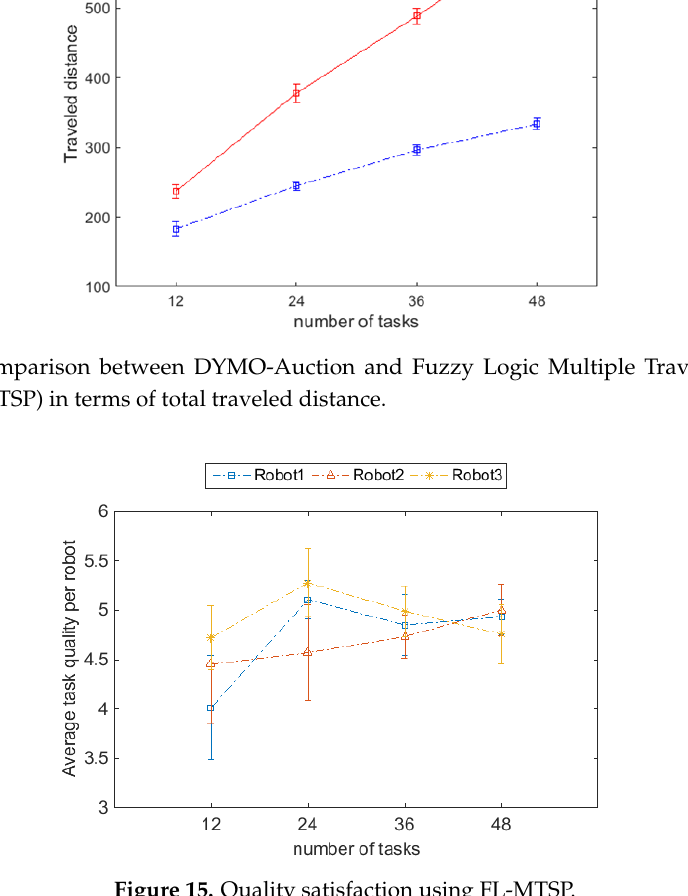
Figure 15. Quality satisfaction using